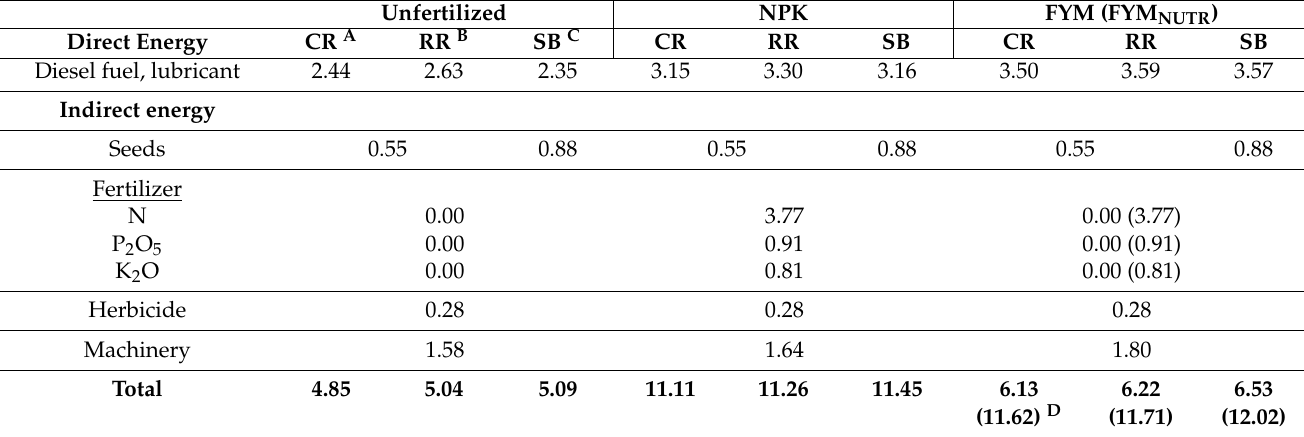
Table 6. Direct and indirect energy input (GJ ha − 1 , mean over years 1960–2019) for continuous winter rye, winter rye in rotation and spring barley in rotation. Unfertilized NPK FYM (FYM NUTR ) Direct Energy CR A RR B Diesel fuel, lubricant Indirect energy Seeds Fertilizer N P 2 O